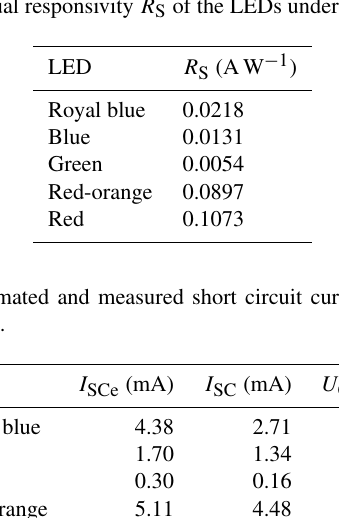
Table 3. Mutual responsivity R S of the LEDs under test.